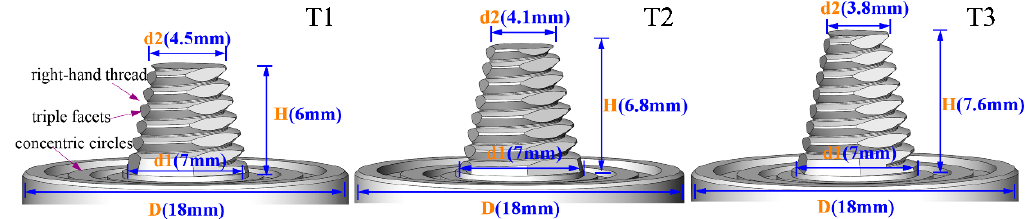
Figure 3. Profiles and main dimensions of tools used in this investigation.